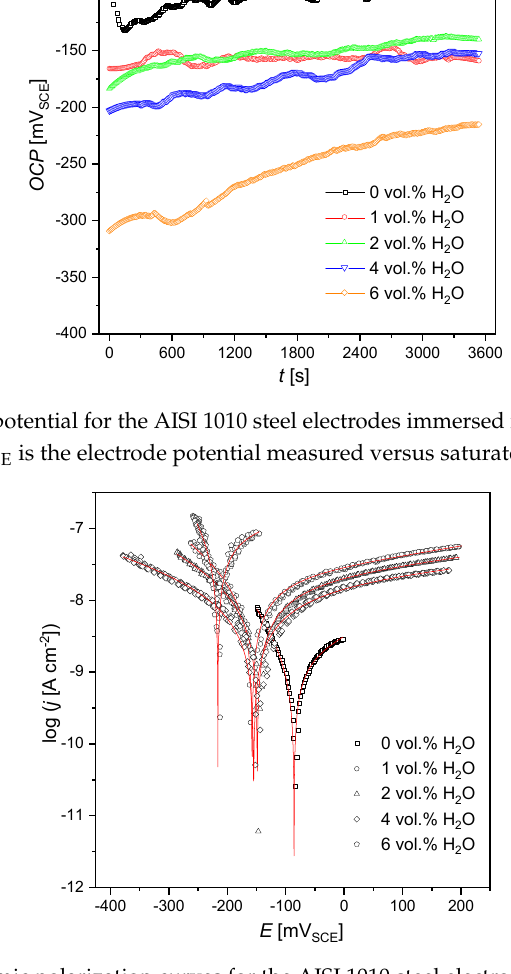
Figure 2. Potentiodynamic polarization curves for the AISI 1010 steel electrodes immersed in sulfolane containing up to 6 vol.% of water; symbols and solid lines represent experimental data and fit of Equation (1), respectively; V SCE is the electrode potential measured vs. saturated calomel electrode. Table 1. Corrosion parameters for the AISI 1010 steel electrodes immersed in sulfolane containing up to 6 vol.% of water; V SCE is the electrode potential measured vs. saturated calomel electrode. Vol.% H 2 O